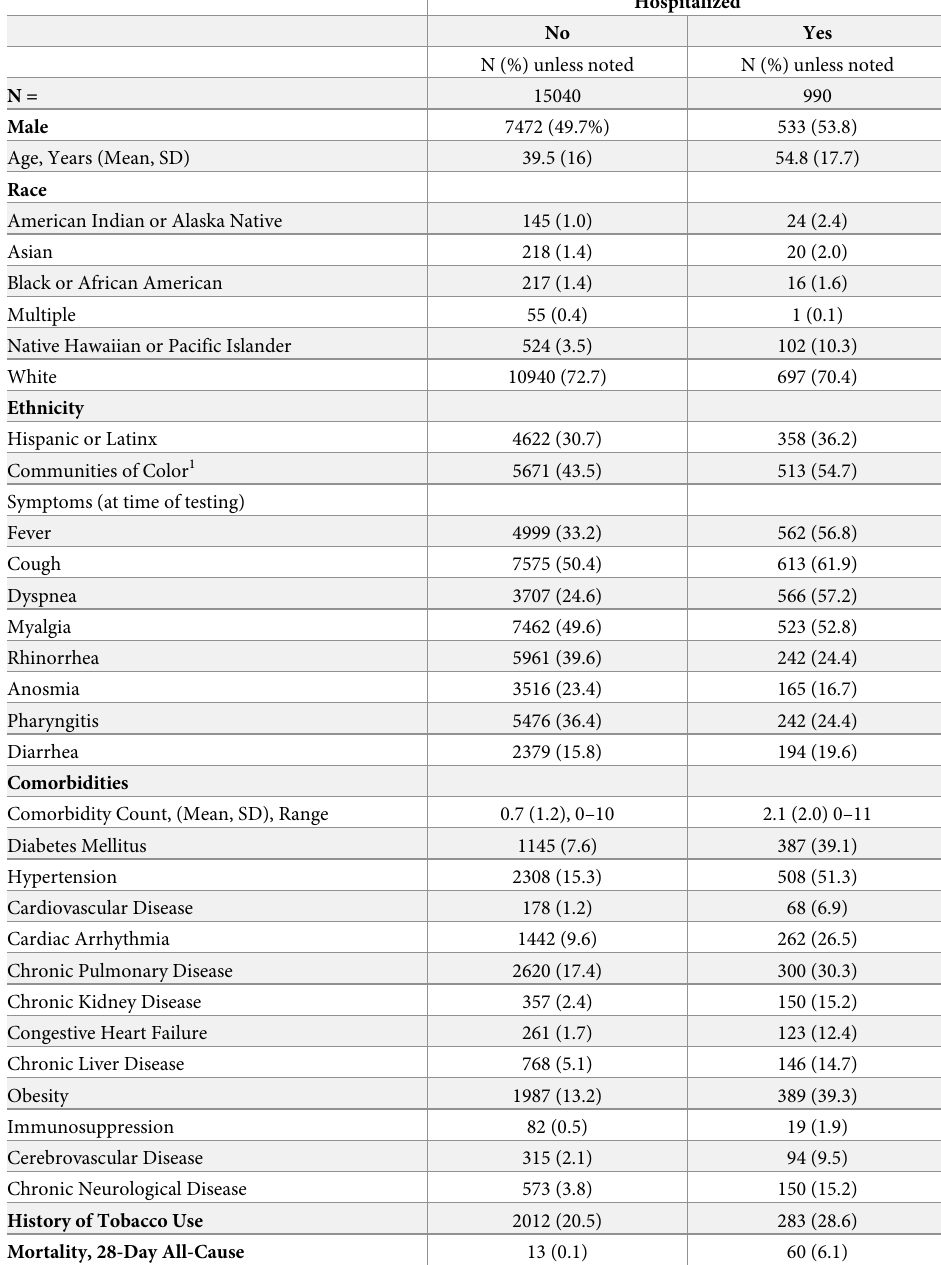
Table 3. Patient characteristics of the derivation cohort stratified by outcome of